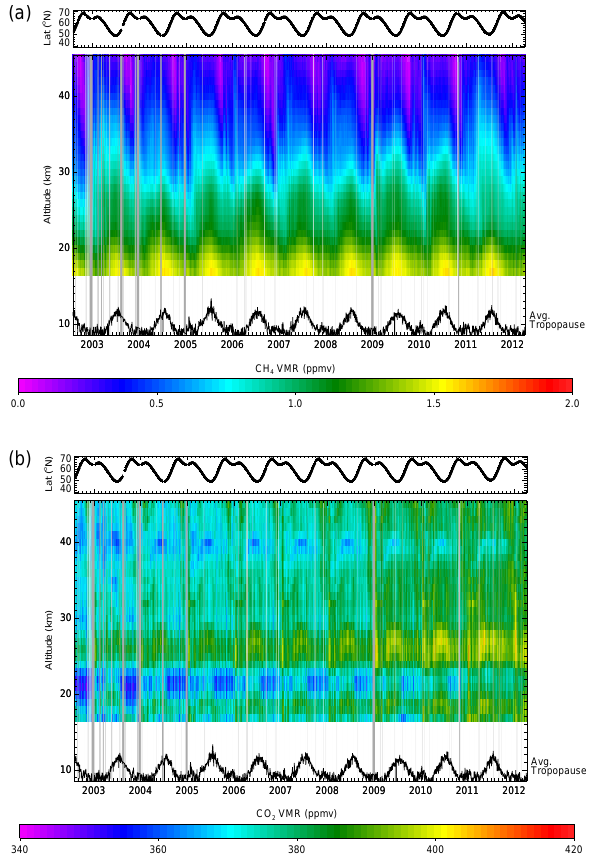
Figure 13. Time series of daily averaged CH 4 (a) and CO 2 (b) profiles August 2002–April 2012. Areas with reduced instrument performance (decontaminations, switch-off, etc.) are masked out by grey bars. The lower, black curve shows average tropopause height derived from ECMWF data. Top graph of each sub-figure shows the tangent latitude of observation.